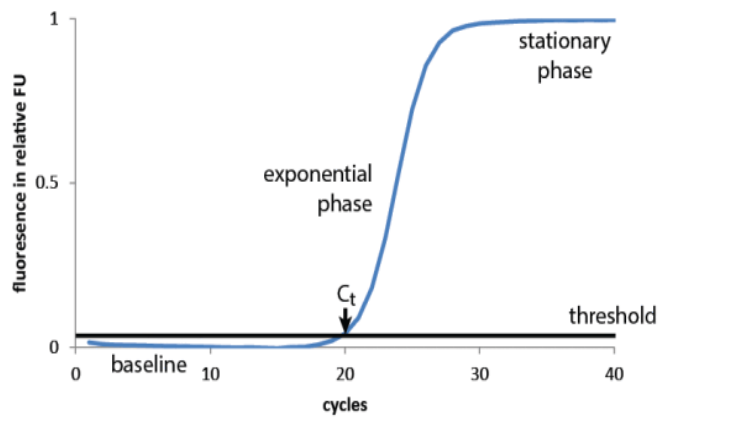
Figure 1. Example of Real Time chart